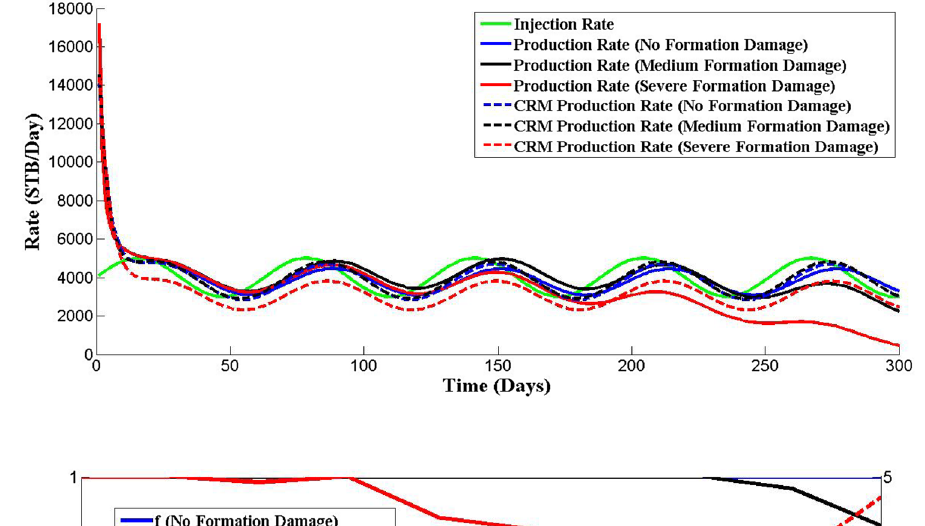
Fig. 5 Connectivity factor and skin versus time for the syn- thetic case